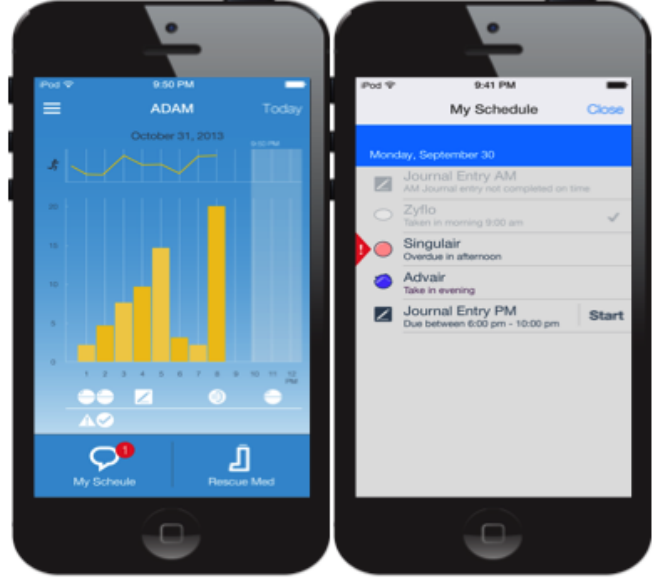
Figure 1. Selected screenshots of the automated device for asthma monitoring